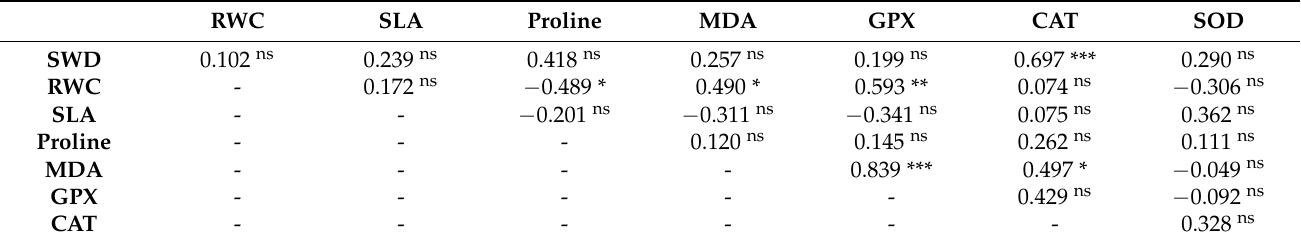
Table 7. Pearson’s correlation test among the studied traits (genotype: ‘Faino Hy’). Significant at p ≤ 0.05 (*), 0.01 (**), and 0.001 (***); not significant